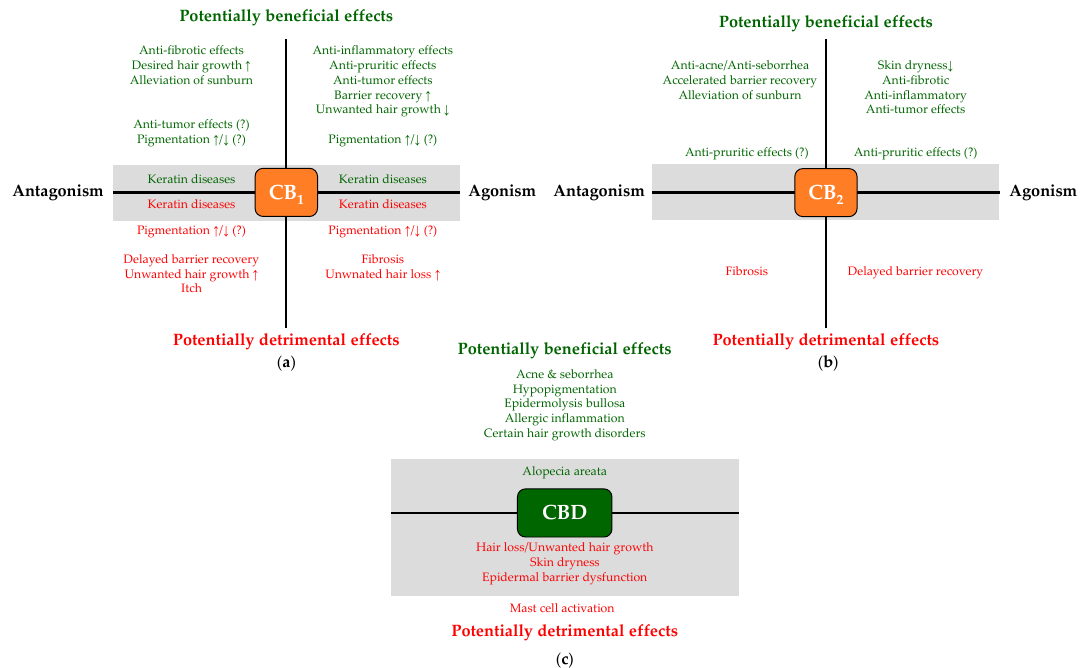
Figure 3. Schematic overview of potentially beneficial and detrimental consequences of pharmacological modulation of CB 1 ( a ) and CB 2 ( b ), as well as of CBD administration ( c ). Note that certain effects (e.g., promoting hair growth) can context-dependently be considered to be a beneficial (e.g., in hirsutism) or a detrimental (e.g., in alopecia) outcome. Question marks indicate controversial data, whereas gray background highlight unproven effects, which are only hypothesized based on indirect evidence; thus, systematic studies are invited to unveil if they indeed develop.